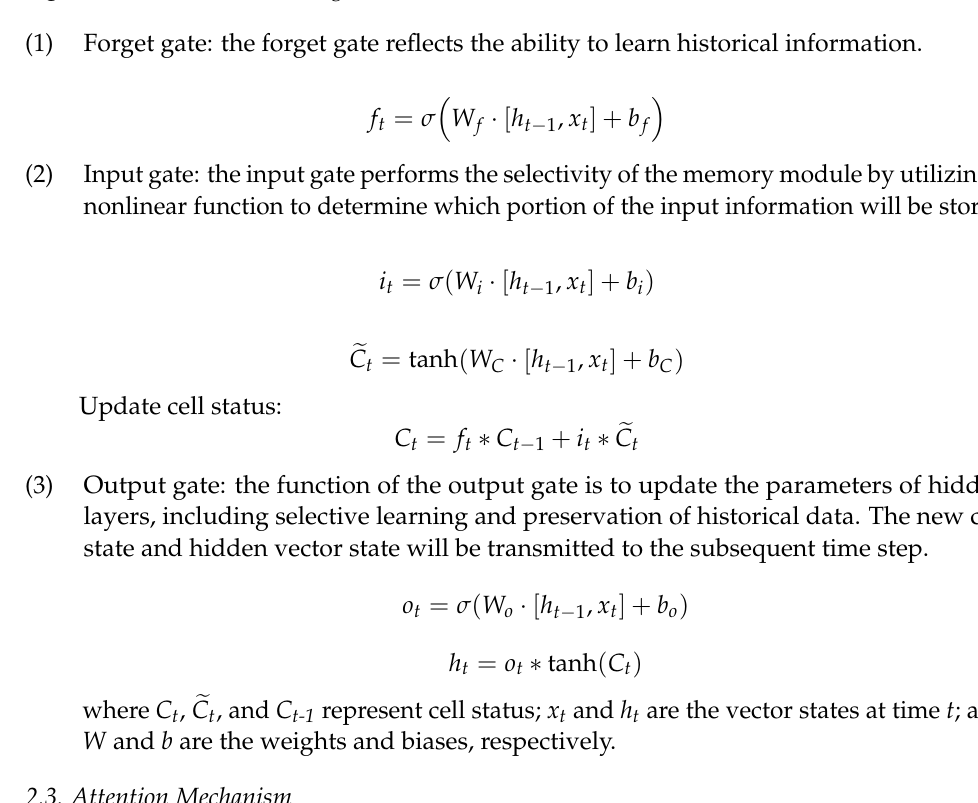
Figure 2. The structure of a single LSTM